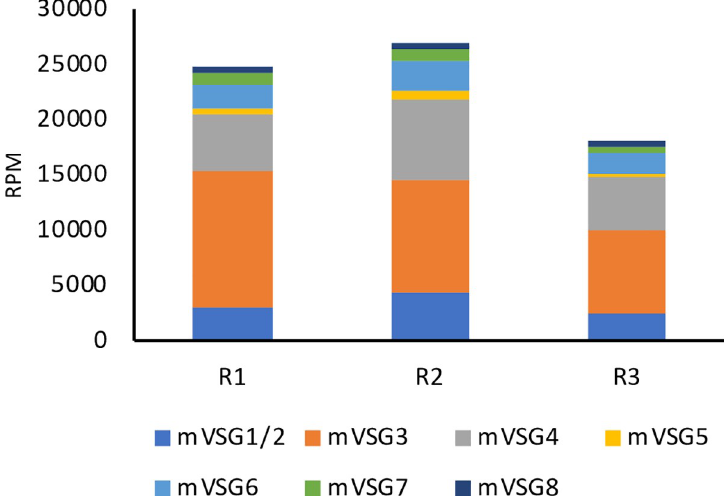
Fig 5. Expression of metacyclic VSGs in the salivary glands. Eight transcripts were assembled from the salivary gland transcriptome. mVSG1 and mVSG2 are alternatively processed transcripts encoding the same protein and are therefore grouped together. The same set of mVSGs was found in three biological replicates (R1–3). RPM: reads per million. Sequence information is provided in S4